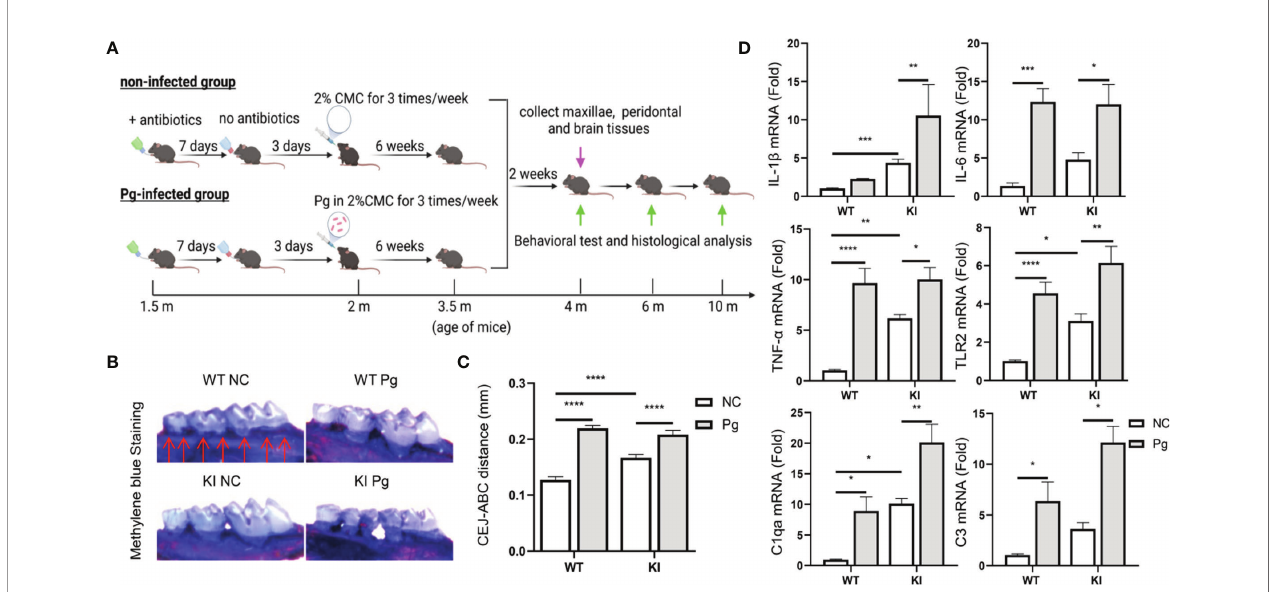
FIGURE 1 | Pg-induced alveolar bone loss and periodontal in fl ammation in App KI and WT mice following oral infection. (A) Schematic of the experimental design used in this study. m, month. (B) Representative methylene blue-stained maxillae from non-infected (NC) and Pg-infected WT and App KI mice (n=9 mice/group). Bone loss was assessed in a total of 7 buccal sites (red arrows) per mouse. (C) Alveolar bone loss in Pg-infected and non-infected WT and App KI mice; mm, millimeter; CEJ-ABC, cemento-enamel junction-alveolar bone crest. (D) In fl ammatory cytokine and complement gene expression in gingival tissues from non-infected and Pg-infected WT and App KI mice. Gene expression was normalized to GAPDH and expressed as fold changes. Samples were done in duplicate (n=7 mice/ group). Data are expressed as mean ± SEM. * P < 0.05, ** P < 0.01, *** P < 0.001, **** P < 0.0001, by two-way ANOVA followed with Tukey